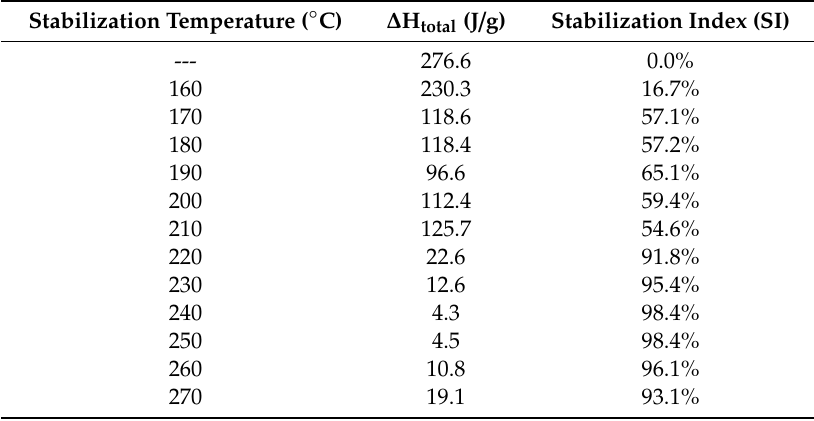
Table 3. Results of thermal analysis of oxidatively stabilized PAN